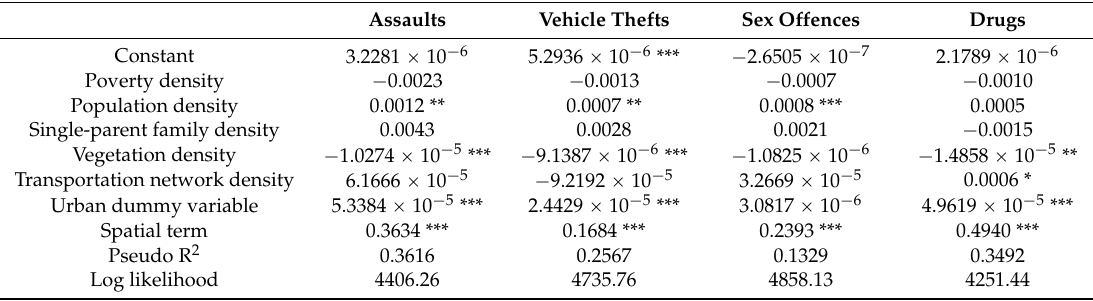
Table 7. Spatial regression results for assaults, vehicle thefts, sex offences, and drugs along the urban central-peripheral